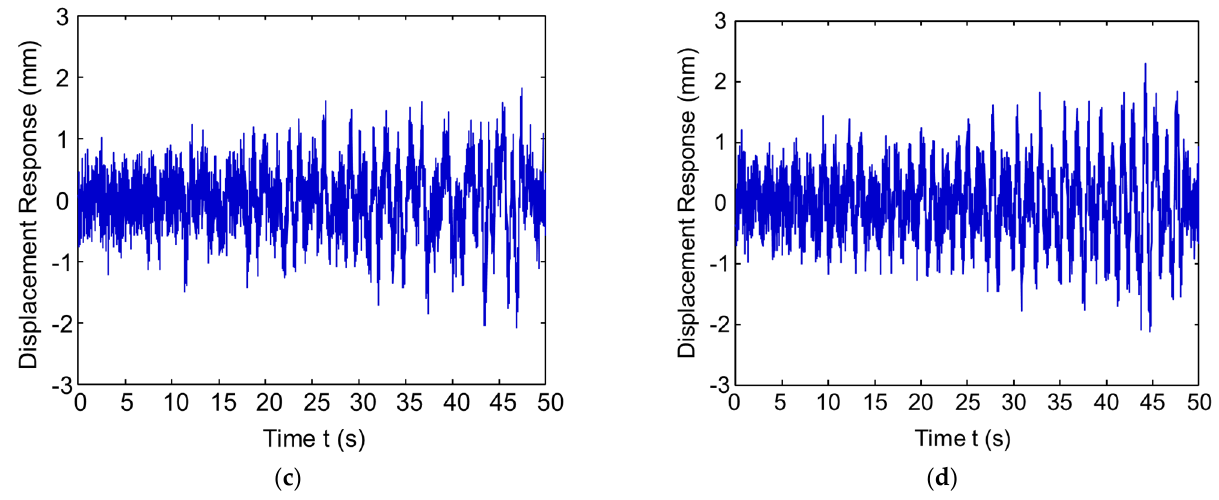
Figure 18. The displacement response of the UDP/DP: ( a ) UDP, D0; ( b ) DP, D1; ( c ) DP, D2; and ( d ) DP, D3.